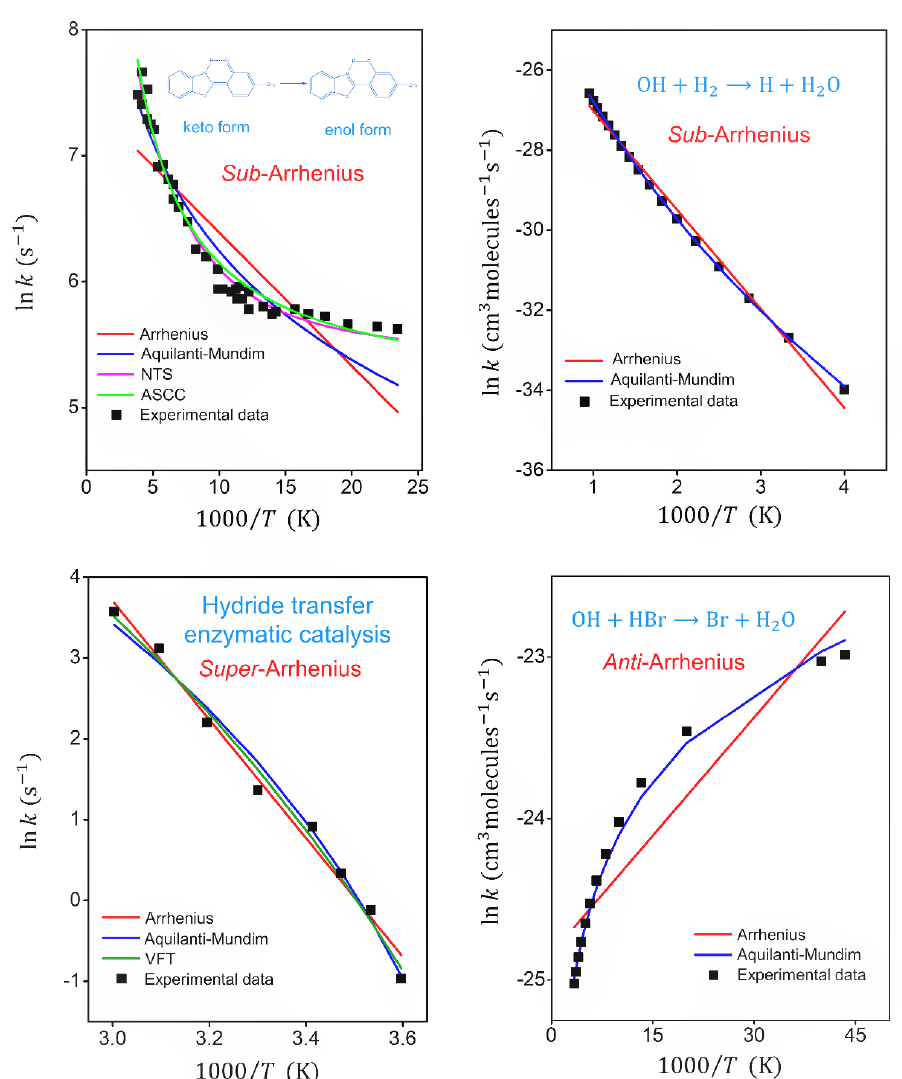
Figure 2. Arrhenius plots comparing the experimental reaction rate constant and fitted formulas for keto – enol tautomerization reaction (sub-Arrhenius behavior under deep tunneling), OH + H 2 ⟶ H 2 O + H reaction (sub-Arrhenius behavior under moderate tunneling), hydride transfer with enzymatic catalysis (super-Arrhenius behavior) and OH + HBr ⟶ H 2 O + Br reaction (anti-Arrhenius behavior). NTS and ASCC formulas were of use for sub-Arrhenius behavior under deep-tunneling regime. The Aquilanti – Mundim formula was of use for sub-Arrhenius cases under moderate-tunneling regime, for super-Arrhenius and for anti-Arrhenius behaviors. VFT also was of use for super-Arrhenius situations. The references of experimental data can be found in Table I. The references of experimental data can be found in Table